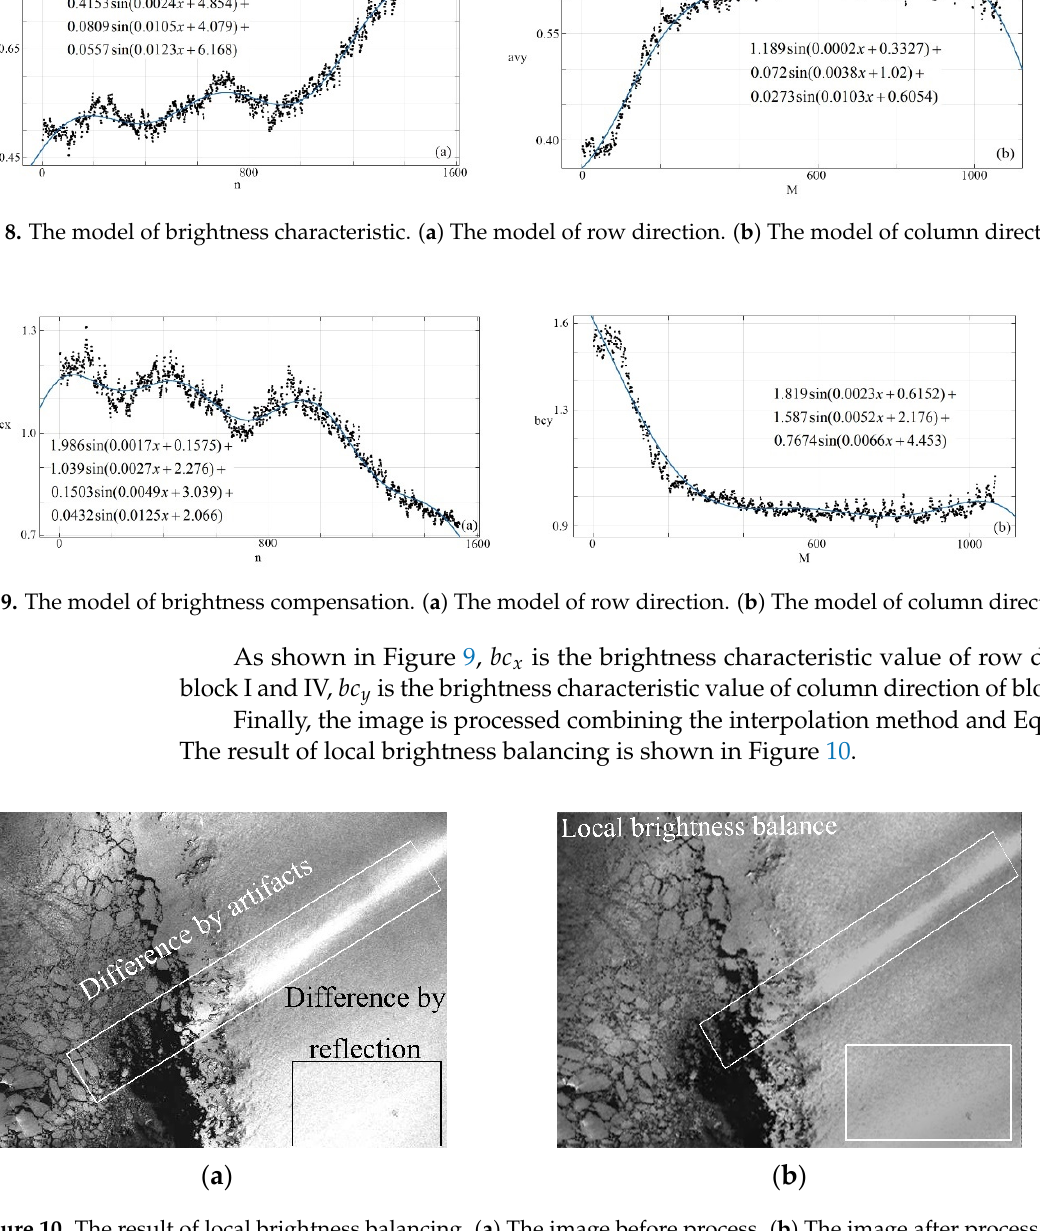
Figure 10. The result of local brightness balancing. ( a ) The image before process. ( b ) The image after process.